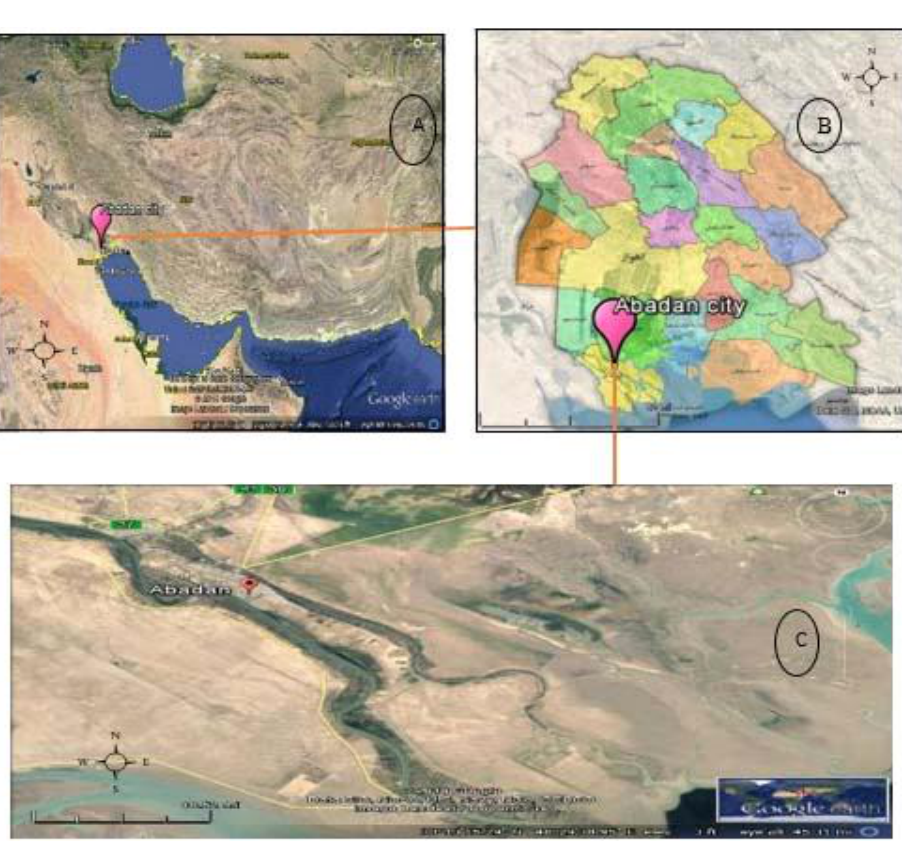
Fig. 1: Geographical location for the region under study in Khuzestan province and Abadan city